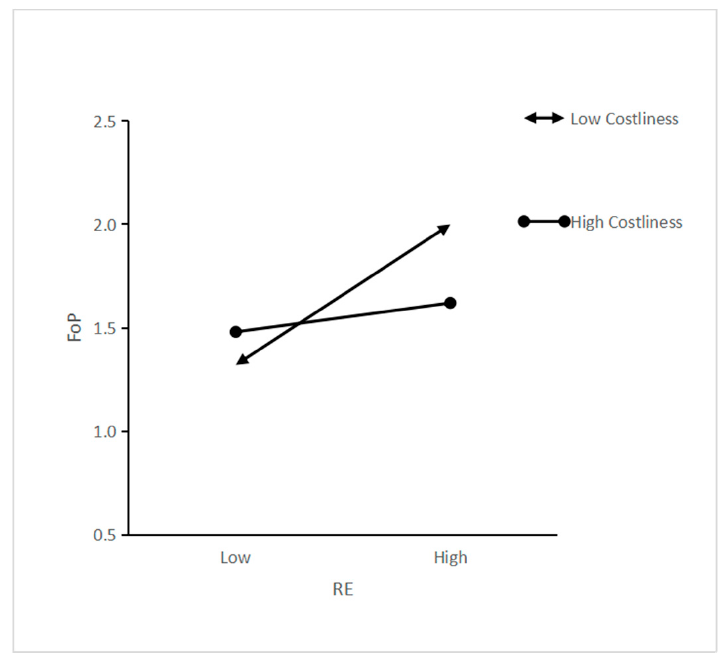
Figure 2. Two-way interaction of recycling effort and costliness.